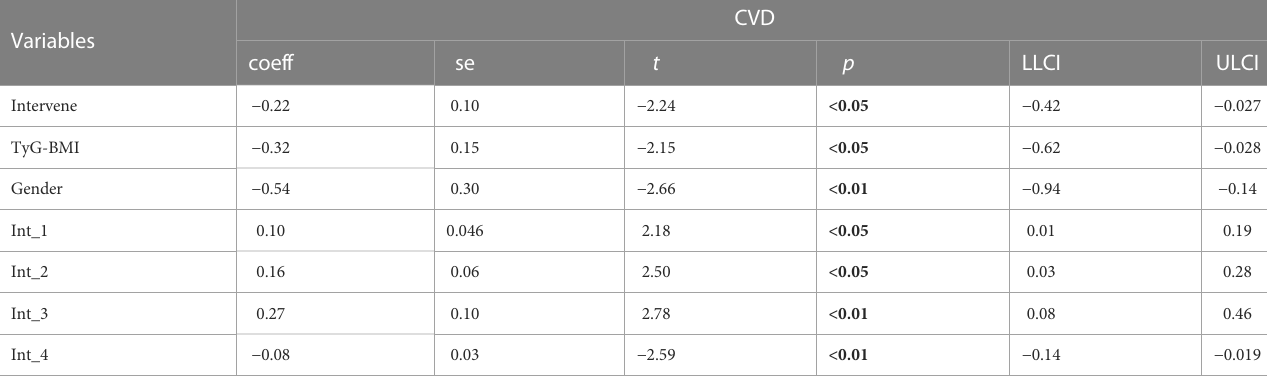
TABLE 20 The moderation analysis between HRBs, TyG-BMI, age, and CVD.